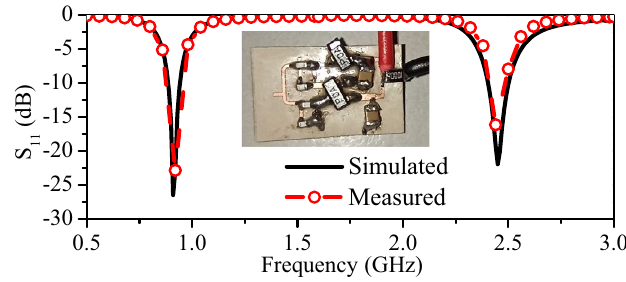
Figure 3. S 11 (measured and simulated) of the dual-band rectifier.